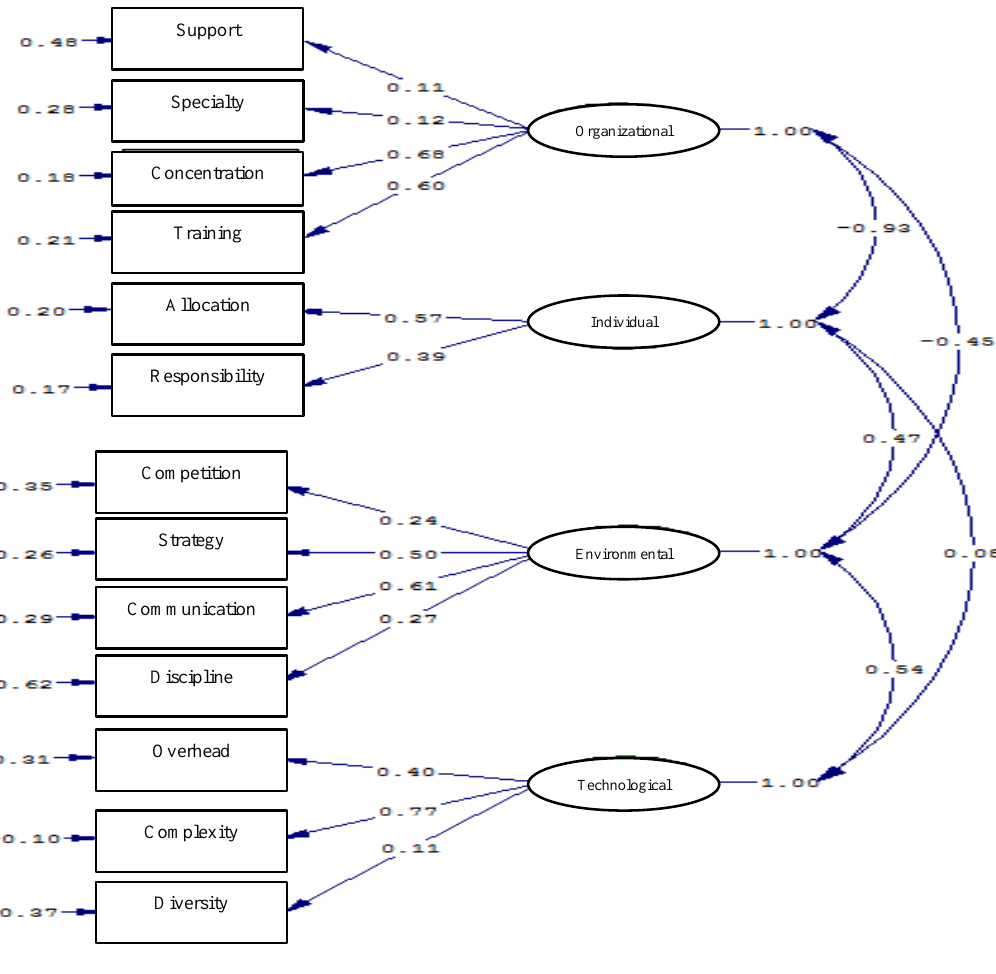
Fig. 1. The results of standard coefficients on SEM